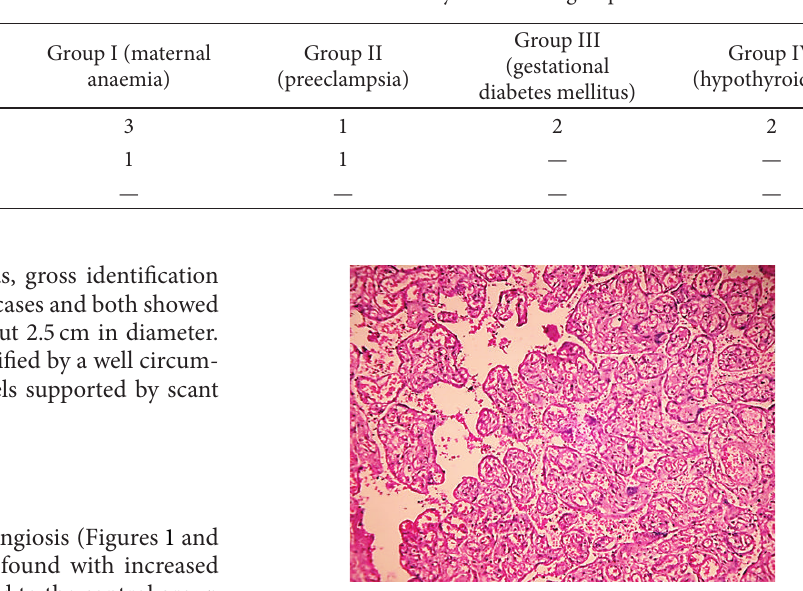
Table 4: Spectrum of villous vascular lesions identified in the study and control groups.